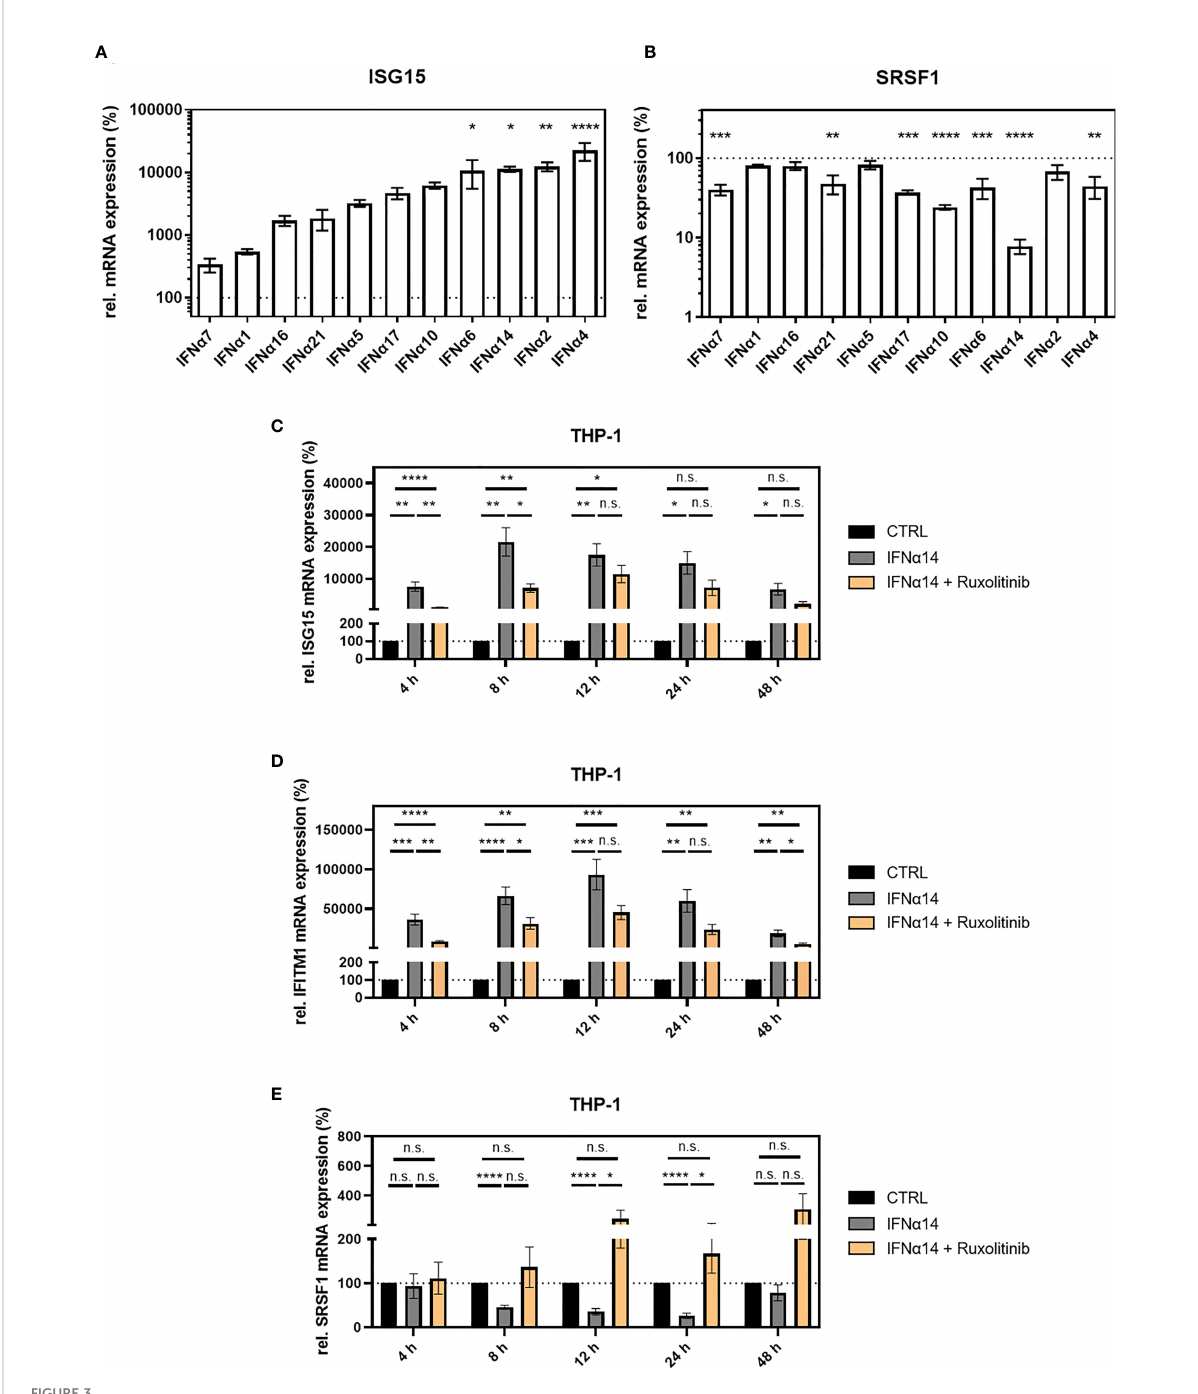
FIGURE 3 SRSF1 expression upon stimulation with IFN a subtypes. Differentiated THP-1 cells were treated with the indicated IFN subtype (10 ng/ml). Twenty-four hours post-treatment, cells were harvested, and RNA was isolated and subjected to RT-qPCR for measurement of relative (A) ISG15 and (B) SRSF1 mRNA expression levels. Statistical signi fi cance was analyzed performing one-way ANOVA with Dunnett post-hoc test (* p < 0.05, ** p < 0.01, *** p < 0.001, and **** p < 0.0001). Mean ( ± SEM) of n = 3 biological replicates is depicted. (C – E) Differentiated THP-1 cells were treated with 1 µM Ruxolitinib or DMSO as mock control1 h before infection using NL4-3 AD8 (1 MOI). Sixteen hours post-infection, cells were washed with PBS and treated with media containing PBS or IFN a 14, and either Ruxolitinib or DMSO. At the indicated time points, wells were rinsed with PBS, and cells were subjected to RNA isolation and RT-qPCR analysis to monitor mRNA expression levels of (C) ISG15, (D) IFITM1, and (E) SRSF1. Groups were compared with two-way repeated-measures ANOVA with Tukey ’ s post-hoc test. ns is not signi fi